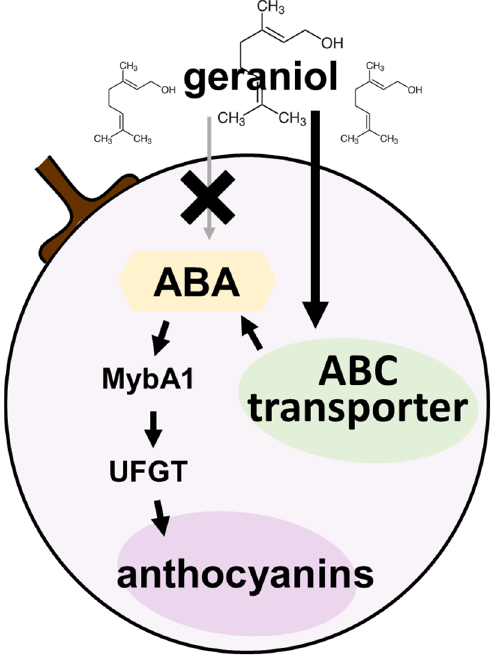
Figure 7. Predicted pathway for geraniol-induced anthocyanin accumulation in grape berry skin.